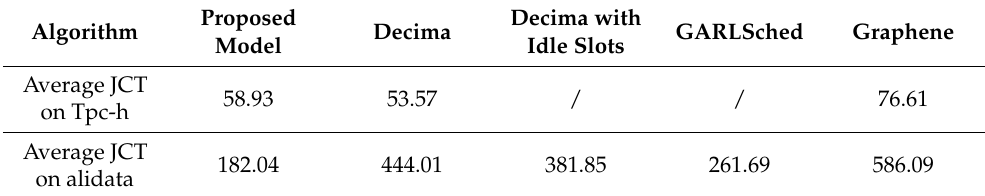
Table 4. Average JCT of different algorithms on Tpc-h and